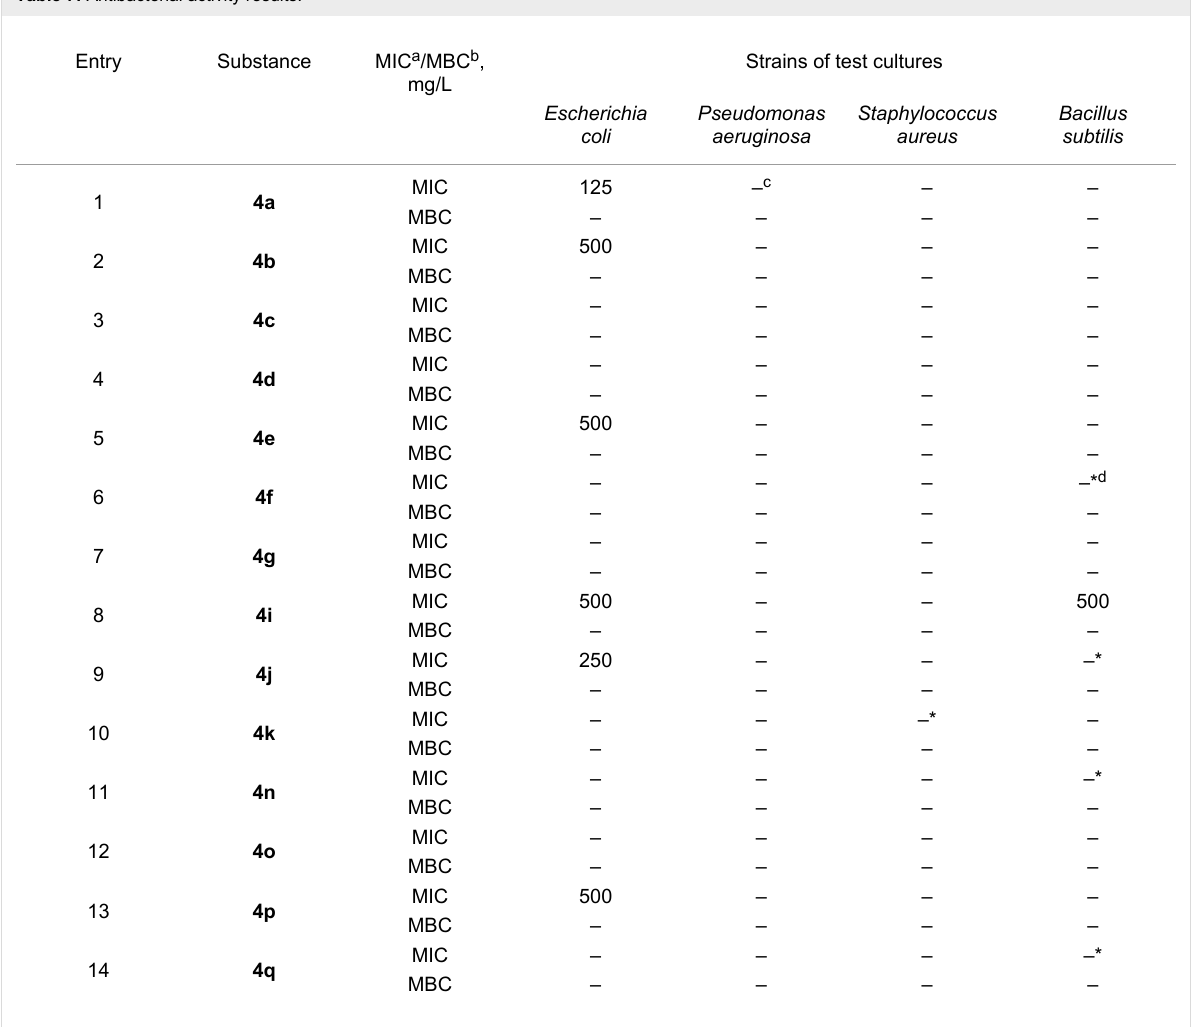
Table 7: Antibacterial activity results.